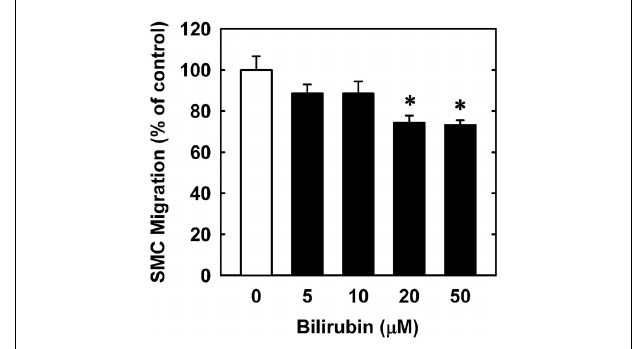
FIGURE 5 | Bilirubin inhibits the migration of human vascular SMCs. Freshly scraped cell monolayers were treated with serum (20%) in the absence or presence of bilirubin (0–50 μ M) and cell migration was determined 18h later. Results are means ± SEM ( n = 3). *Statistically significant effect of bilirubin.